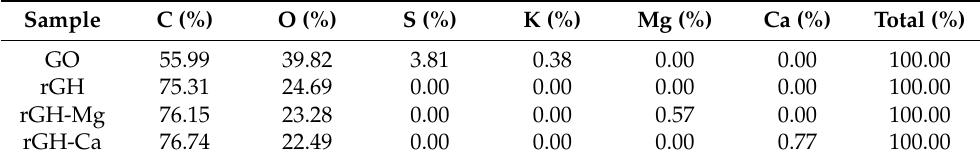
Table 2. Elemental composition of GO, rGH, rGH-Mg and rGH-Ca obtained from EDX